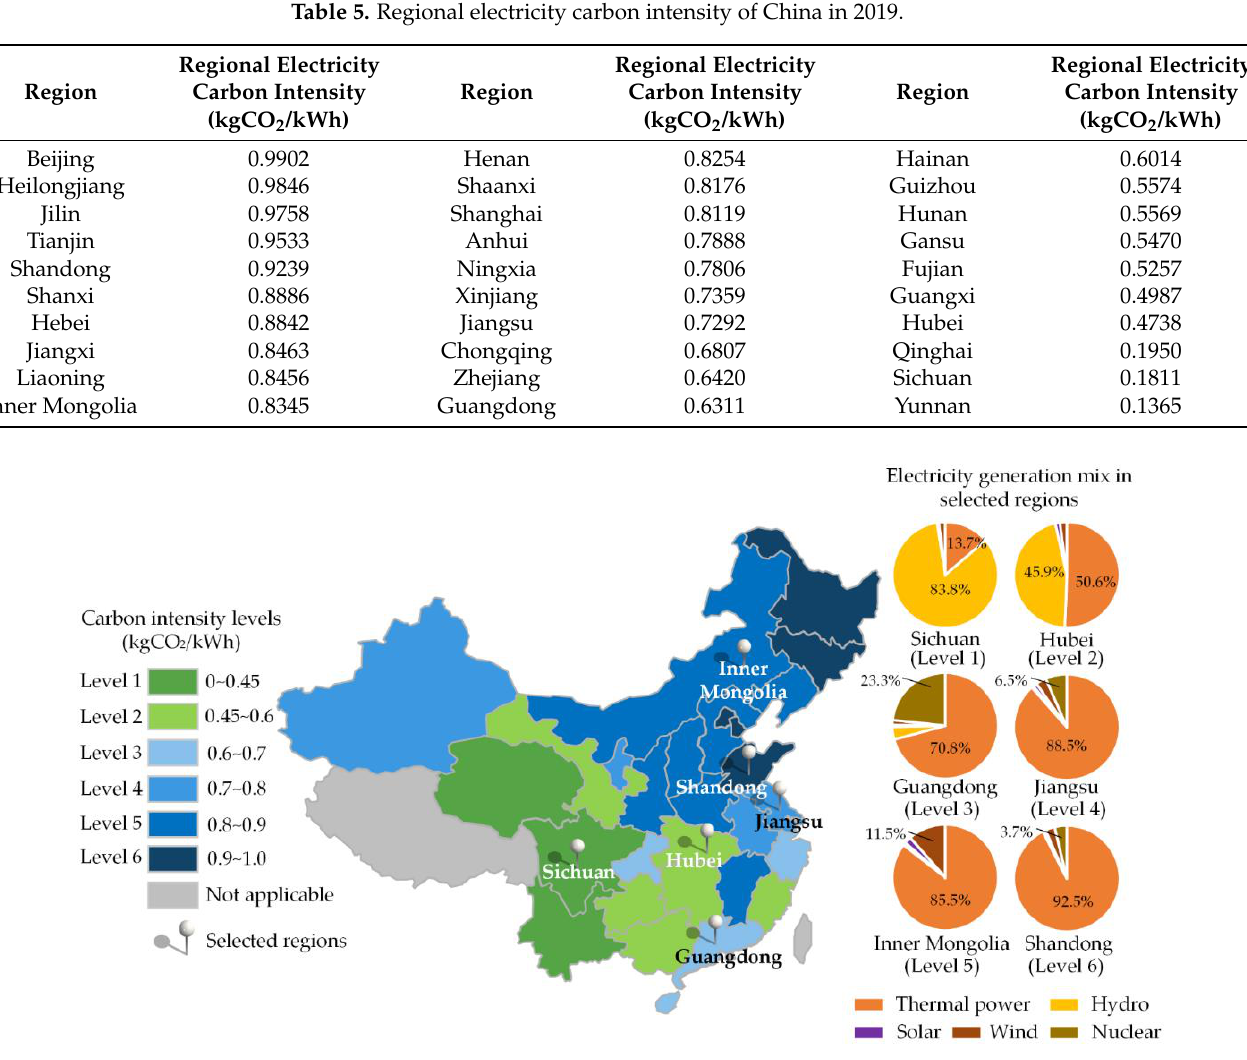
Figure 4. Regional disparity in electricity carbon intensity and electricity generation mix in represen- tative regions.